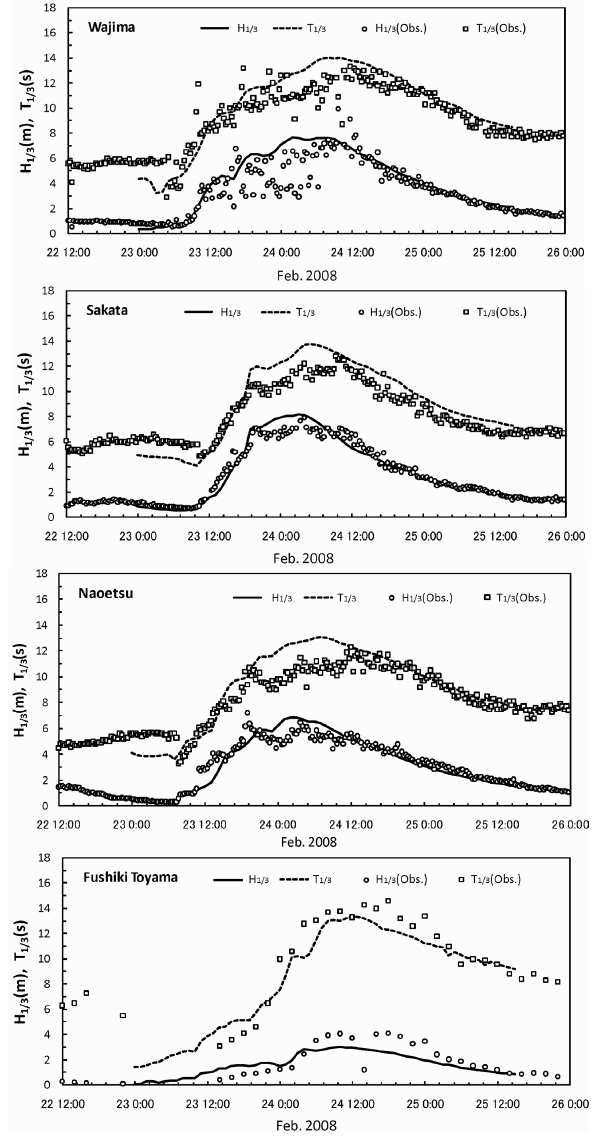
Fig. 15. Comparisons of observations and calculations of wave characteristics at Wajima, Sakata, Naoetsu and Fushiki Toyama in Japan for the event of February 2008.